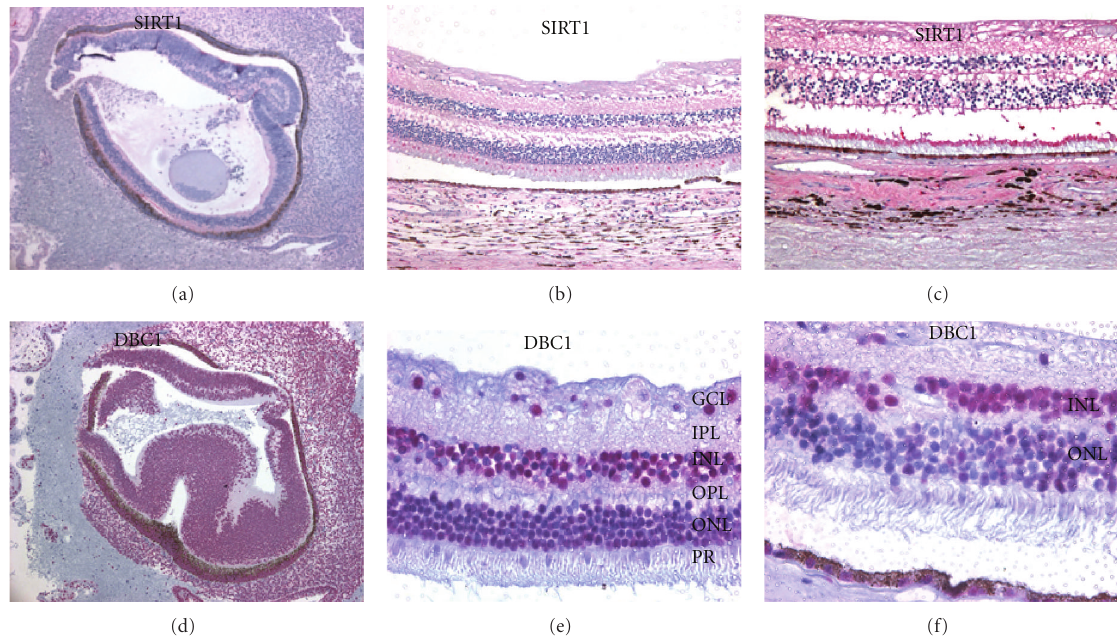
Figure 1: Expression of SIRT1 and DBC1 in fetal and adult human eyes. SIRT1 was exclusively cytoplasmic in the retinas of all fetal ((a): 100x) and adult ((b)-(c): 160x) eyes and seen in GCL, IPL, OPL, and photoreceptor (PR) inner segments. DBC1 was exclusively nuclear in fetal eyes ((d): 100x) with stronger staining in the primitive INL than the ONL. In adult eyes ((e): 400x, (f): 640x), DBC1 was exclusively nuclear in the INL and ONL and both nuclear and cytoplasmic (weak) in the GCL. Of note, GCL and INL nuclei stained stronger than ONL nuclei in all